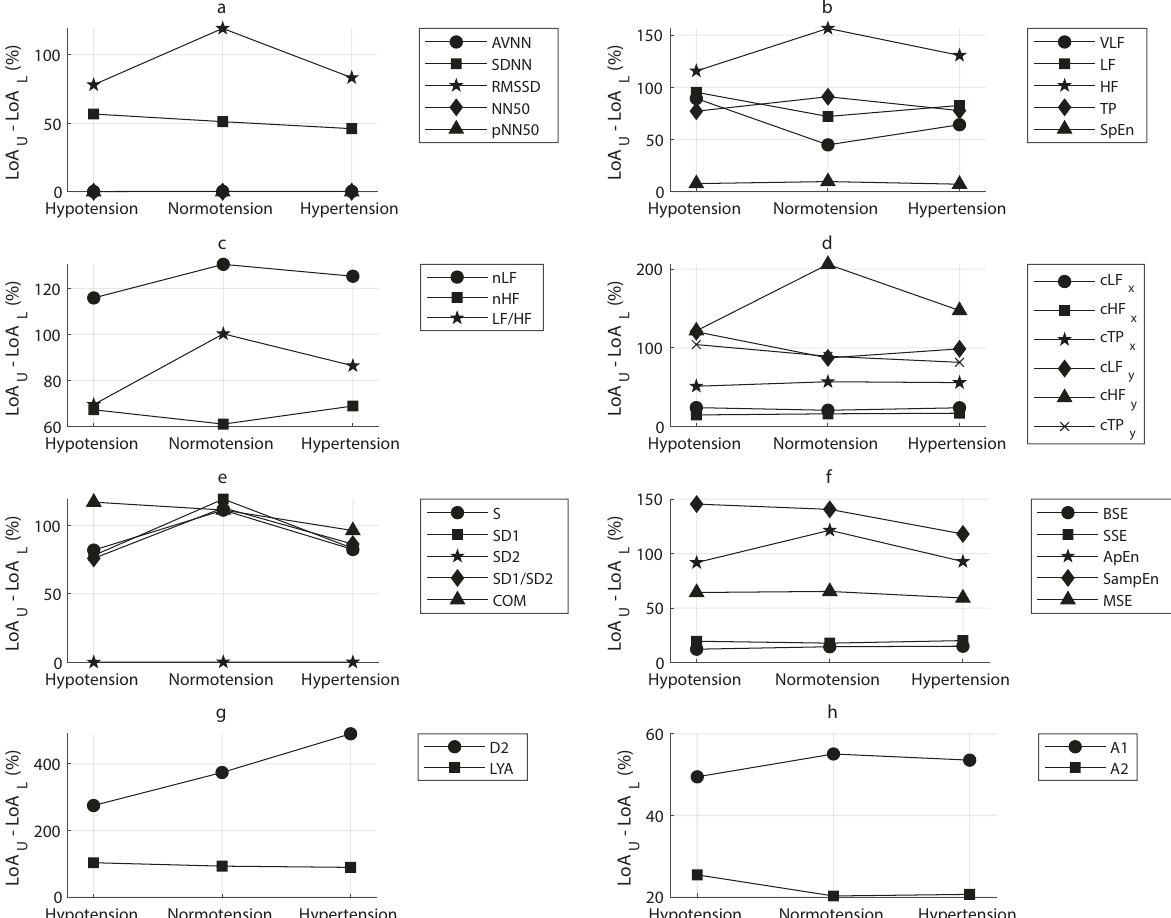
Fig. 3 Differences between upper (LoA U ) and lower (LoA L ) limits of agreement obtained from Bland – Altman analysis comparing indices measured from pulse rate variability and heart rate variability. The limits of agreement were obtained from the Bland – Altman analysis performed with the extracted indices in each blood pressure state (hypotension, normotension, and hypertension). Indices analysed were a time-domain indices, b absolute and entropy indices from the frequency domain, c relative indices from the frequency domain, d centroid- related indices from the frequency domain, e Poincaré plot indices, f entropy-related indices, g phase-related indices, and h indices resulting from the detrended fl uctuation